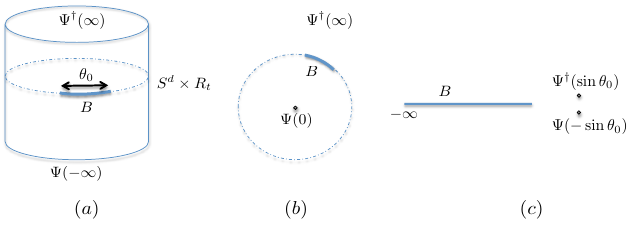
R d +1 conformal